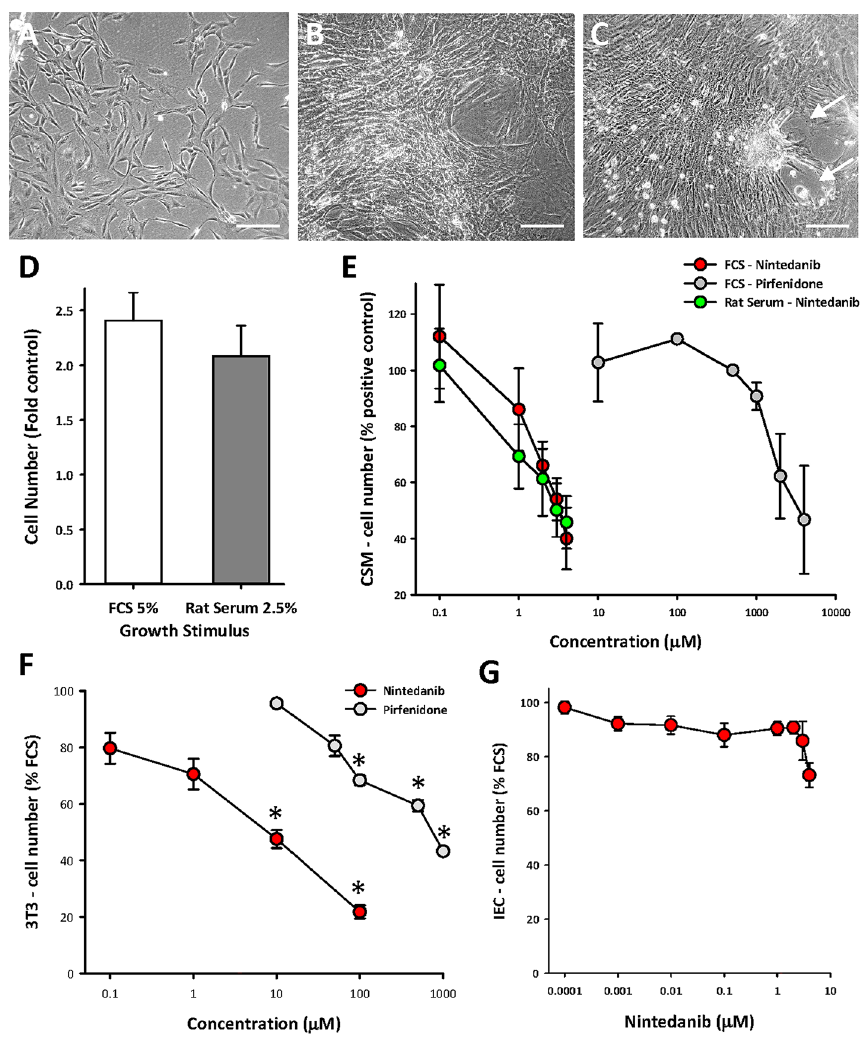
Figure 1. NIN limits serum-stimulated growth of smooth muscle cells from circular smooth muscle layer of adult rat colon (CSMC) in vitro. ( A – C ) Representative phase contrast images of culture model of CSMC at passage 14 in vitro after plating, showing sub-confluent appearance ( A ), progressive growth to post-confluence with overlapping cell layers ( B ) and retraction in local areas at when maintained at high density (e.g., arrows) ( C ). Scale bars, 200 µM. ( D ) Growth assays showing similar outcomes after 48 h stimulation between fetal calf serum (FCS, 5%) and adult rat serum (RS, 2.5%), with p < 0.05 vs control, n = 5 cell lines, each with triplicate assays. ( E ) Nintedanib inhibits stimulation of growth of CSMC by FCS or RS with greater sensitivity than pirfenidone. p < 0.05 vs control for all data with nintedanib > 0.1 µM; p < 0.05 for pirfenidone ≥ 2 mM; n = 5 cell lines with triplicate assays. ( F ) Similar outcomes to ( E ) for inhibition of FCS-induced growth of fibroblast 3T3 cells. *p < 0.05 vs control. ( G ) Lack of effect of nintedanib on FCS-induced growth of rat intestinal epithelial cells